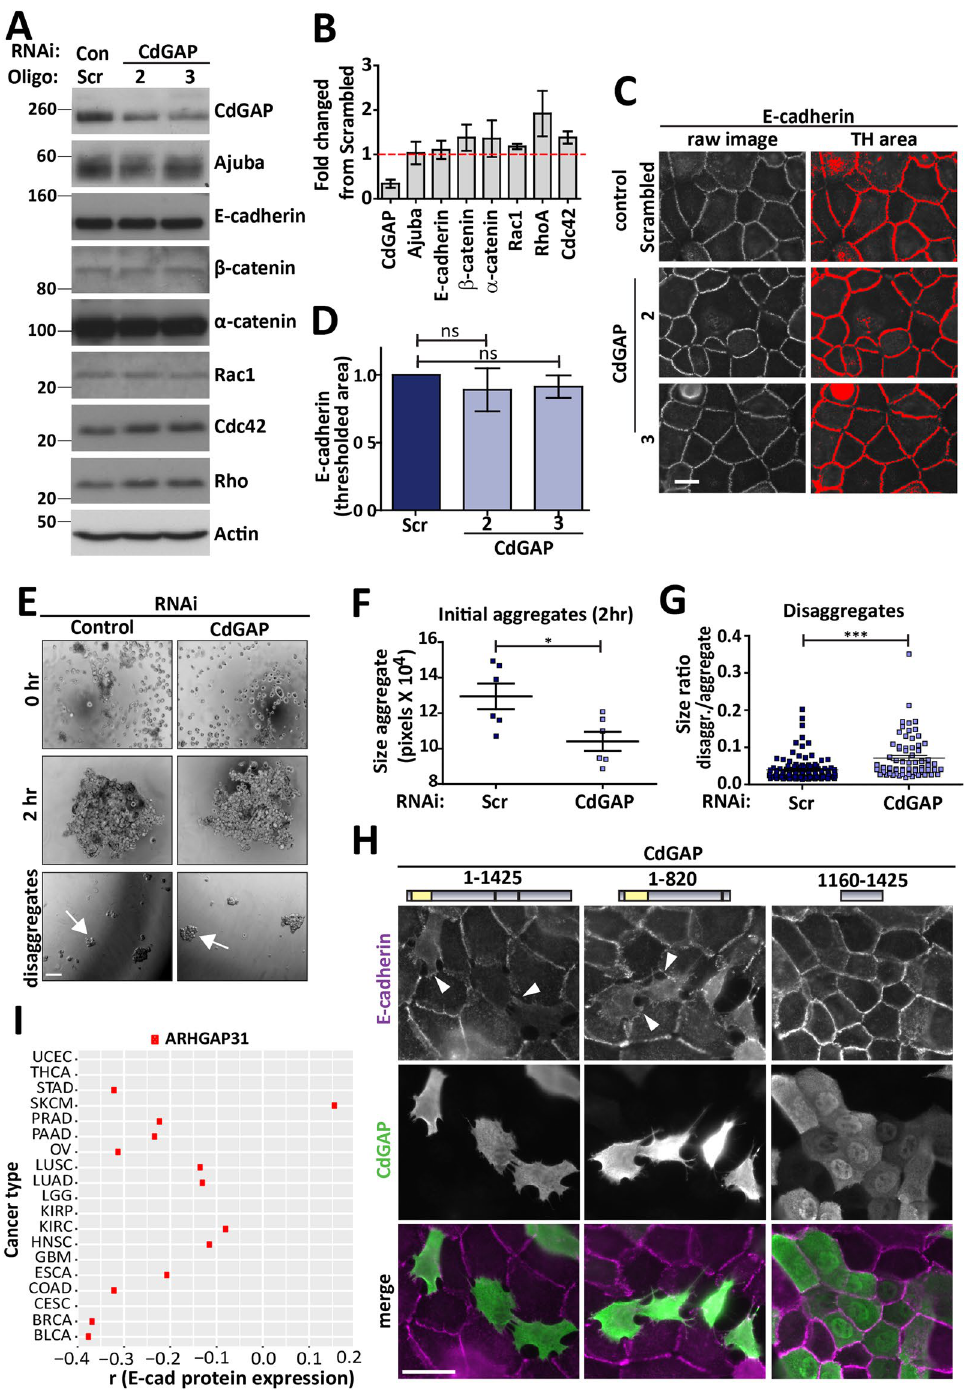
Figure 1. CdGAP regulates adherens junction maintenance. ( A – D ) Keratinocytes grown in low calcium medium were depleted of CdGAP using two specific oligonucleotides (oligo 2 and oligo 3) for 48 hours. ( A ) Cell lysates were prepared and probed for proteins shown on the right hand side of the panels. Molecular weight markers are shown on the left. ( B ) Graph shows the total levels of junctional proteins in cells depleted of CdGAP relative to scrambled or non-targeting siRNA-treated control cells. ( C , D ) Confluent monolayers were induced to form junctions for 30 minutes, fixed, and stained for E-cadherin (raw image). Images were collected from a wide-field microscope and processed for E-cadherin levels at the junction (TH area). ( D ) Graph shows the mean thresholded area E-cadherin for each condition. Values are expressed relative to the control non-targeting oligonucleotide. ( E – G ) Keratinocytes were dissociated into a single cell suspension and placed into at least six hanging drops per condition in a humid chamber (0hr). Cells were allowed to aggregate for 2 hours (2 hr), dissociated by pipetting and all the resulting disaggregates imaged (disaggregates). The size of initial aggregates ( F ) and all disaggregates formed post-disruption were measured. The size of disaggregates was